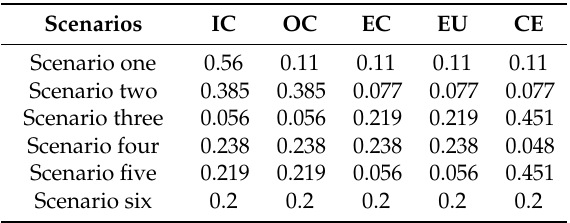
Table 8. Weight of five criteria under six